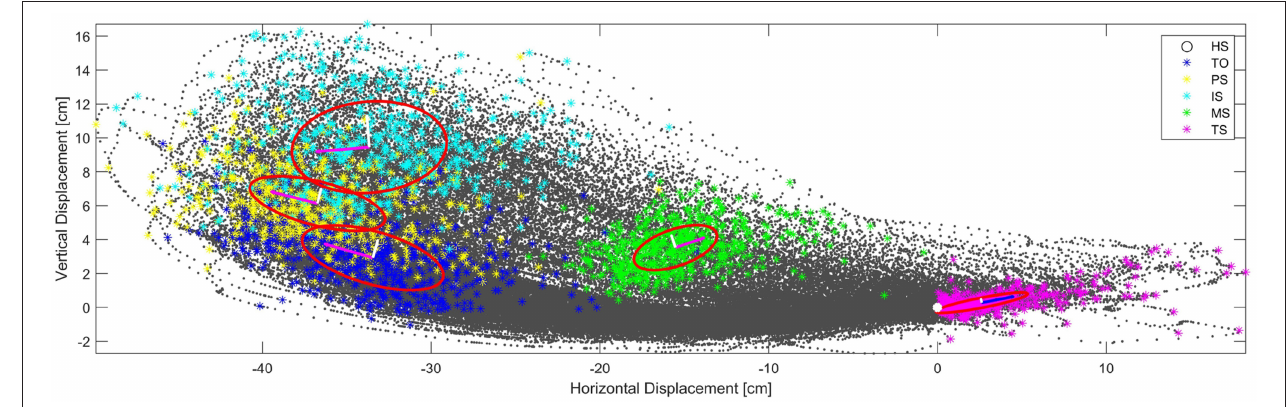
FIGURE 6 | Gait cycle of all subjects aligned by HS for all repetitions of the trial SL = 30[ cm ]. Eigenvalue Decomposition for the centroids of Key Events. Heel Strike is placed in coordinates (0,0) and marked with a white cross. Toe Off events are shown in blue, PS are shown in yellow, IS are shown in cyan, MS are shown in green and TS are shown in magenta. Confidence ellipses are shown in red. Centroids and maximun and minimum variance are shown as vector components. Both SL = 45[ cm ] and SL = 60[ cm ] had similar results.